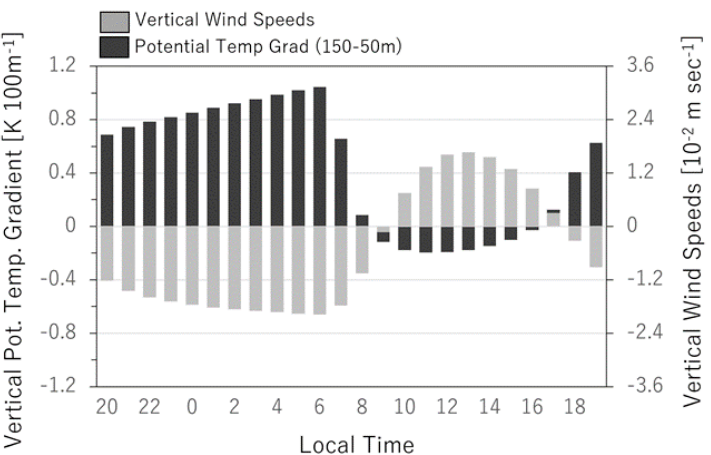
Figure 5. Area-averaged annual mean diurnal variation of the vertical potential temperature gradient (black bars) between 50 and 150 m above ground level and vertical velocity (grey bars) at 100 m above ground level.